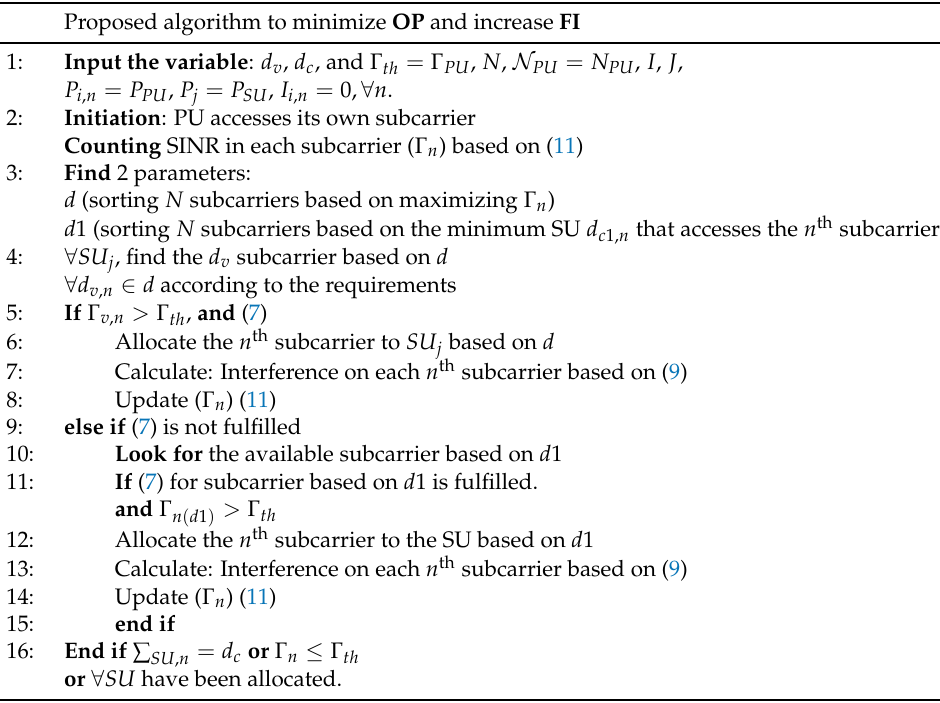
Table 2. ILRA-FM algorithm (Type